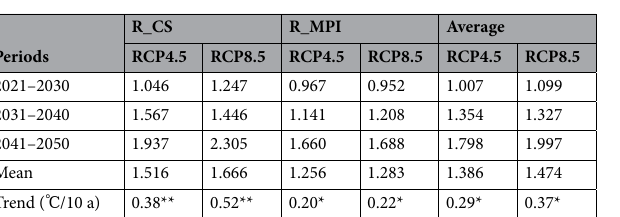
Table 9. Changes and trends of T 2m from R_CS and R_MPI under the RCP4.5 and RCP8.5 scenarios in different periods. *indicates a significant value at the 0.01 level. **indicates a significant value at the 0.05 level.